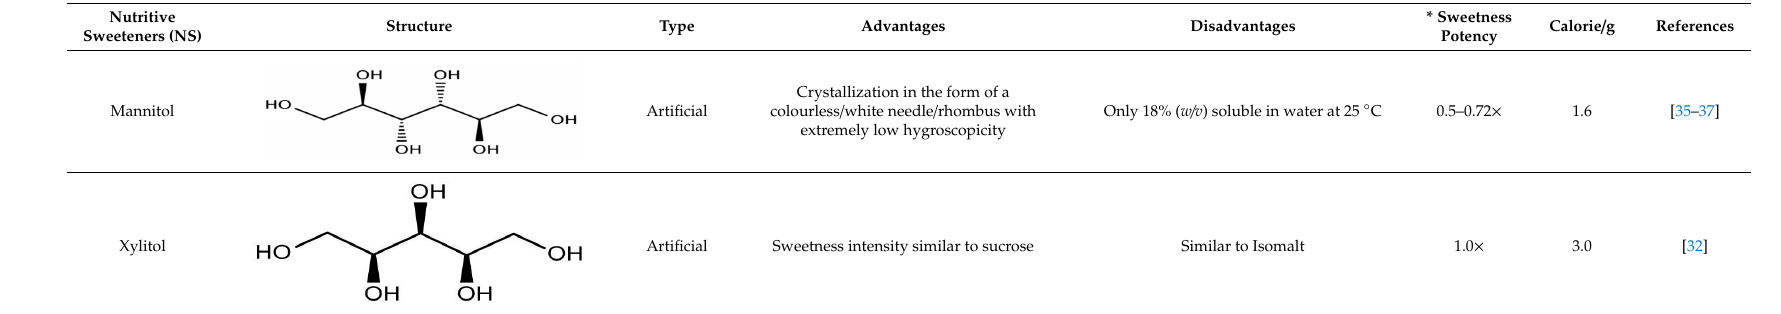
Table 2. Natural and artificial non-nutritive sweeteners (NNSs) used for sugar reduction in dairy